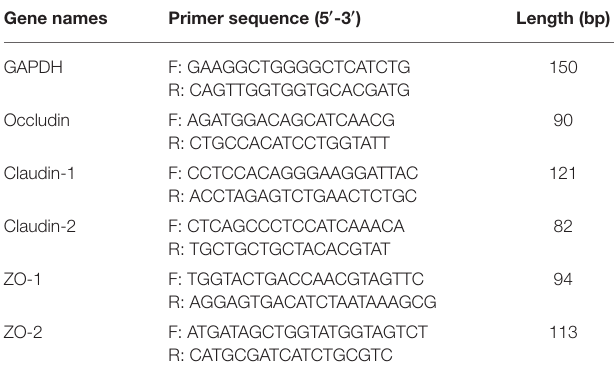
TABLE 2 | Sequence and parameters of primers for